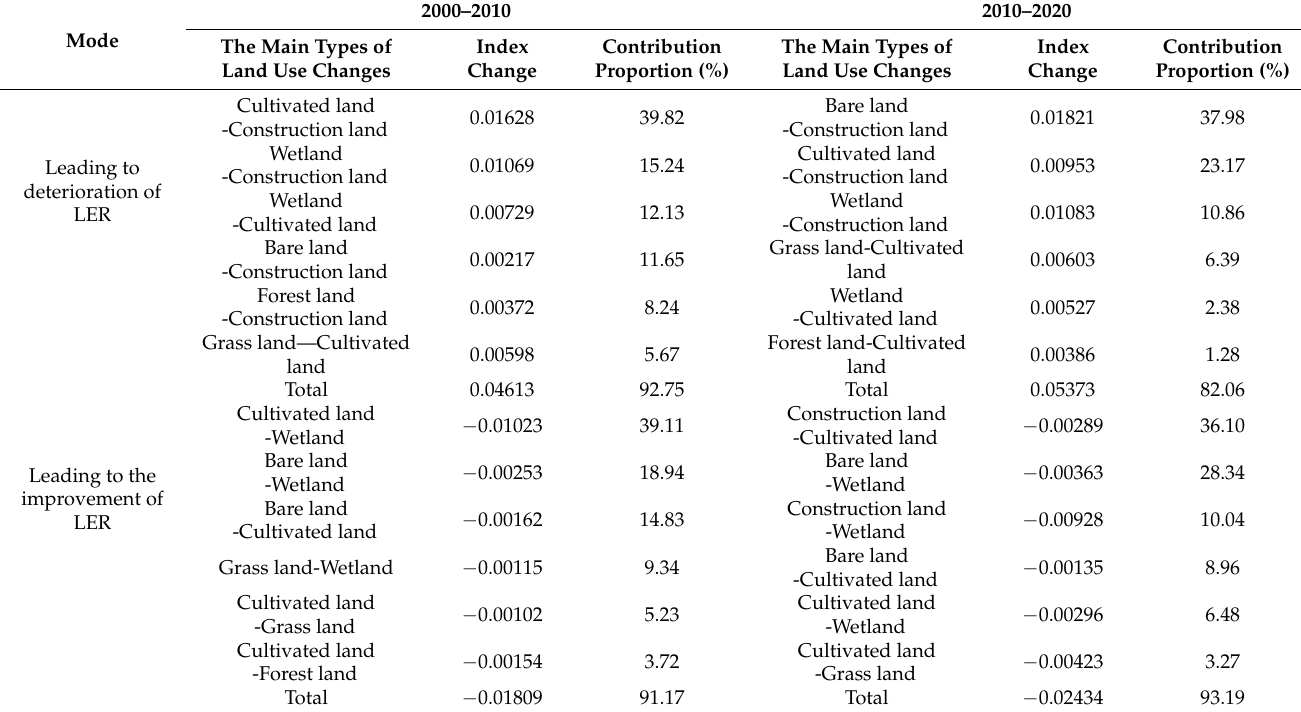
Table 5. The main types of land use changes that affect LER and their contribution rate to ecological risks.